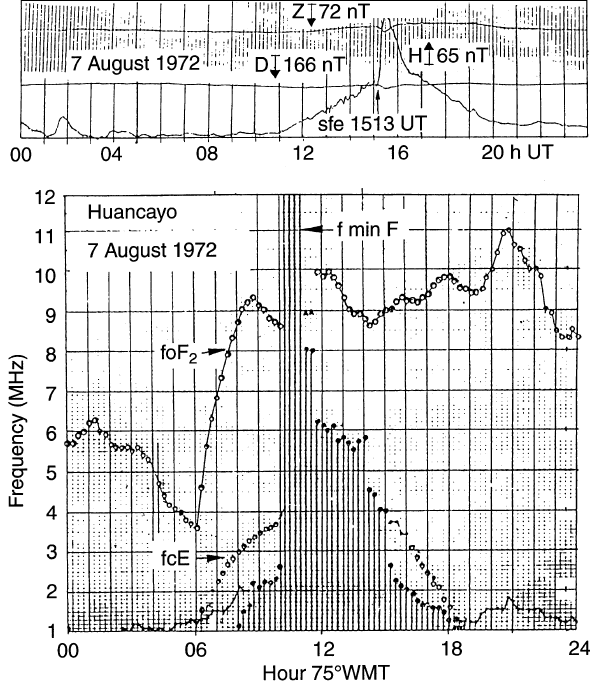
Fig. 10. Magnetograms and ionospheric f-plots at Huancayo asso- ciated with solar flare on August 7,